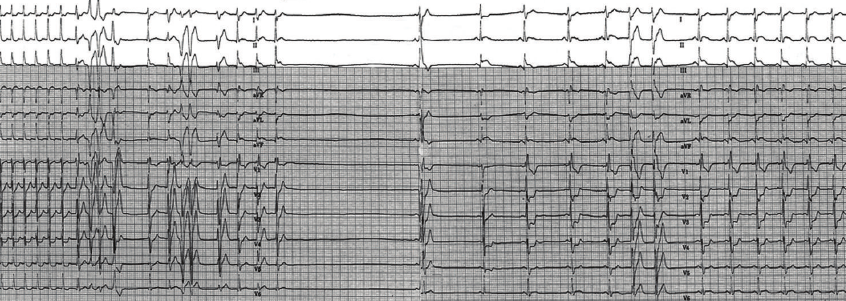
Figure 2: Continuous ECG recording depicts the response to the second dose of adenosine (12mg). After the initial delayed conduction in the atrioventricular node and sinus node, sinus pause arose. Sinus rhythm then resumed and ST-segment elevation in leads II, III, and aVF with ST-segment depression in leads I, aVL, and V1-V3 are